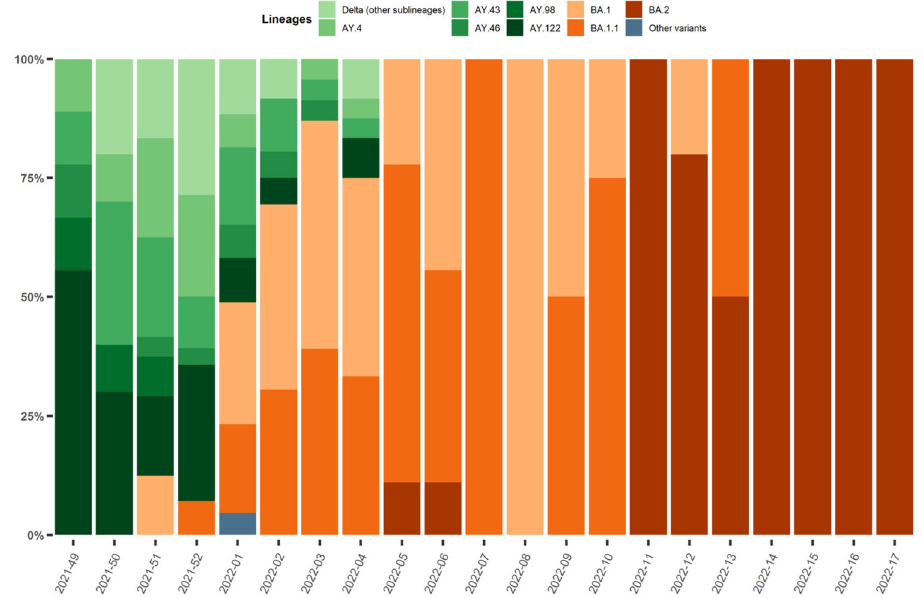
Fig. 1 | Dynamics of infecting SARS-CoV-2 variants during the study period in patients requiring intensive care hospitalized in the 20 participating centers. Delta lineages/sublineages are in green, Omicron lineages/sublineages are in